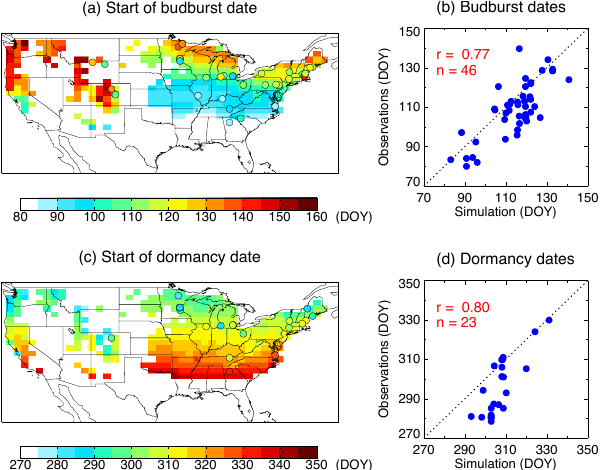
Figure 3. Comparison of the simulated (a, b) budburst and (c, d) dormancy dates with in situ observations (colored circles) from the USA National Phenology Network for 2011–2012. Simulations are performed with the spring model S9 and autumn model A4. The coverage of colored patches in (a) and (c) differs from that in Fig. 1 because values at and beyond the low end of color scales have been shown in white. The number of the sites and the correlation coefficients are shown in the scatter plots. The number of sites shown in the plot is much fewer than the total of 588 because only a small portion of the sites have continuous records for both years and a stringent screening process is applied to derive phenological dates (see Supplement). The separate evalu- ations in 2011 and 2012 are shown in Figs. S12–S13.